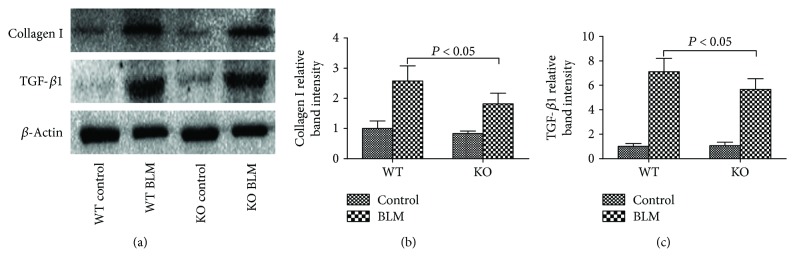
Effect of 5-HT on fibrosis-related gene expression levels induced by bleomycin in mice. The mice in the WT and KO control, WT BLM, and KO BLM groups were sacrificed on day 21. Western blotting was adopted to detect the expression of (a) collagen I and transforming growth factor- (TGF-) β1 in the lung tissues. The band intensities of (b) collagen I and (c) TGF-β1 were analyzed. All data were expressed as mean ± SD, n = 6.